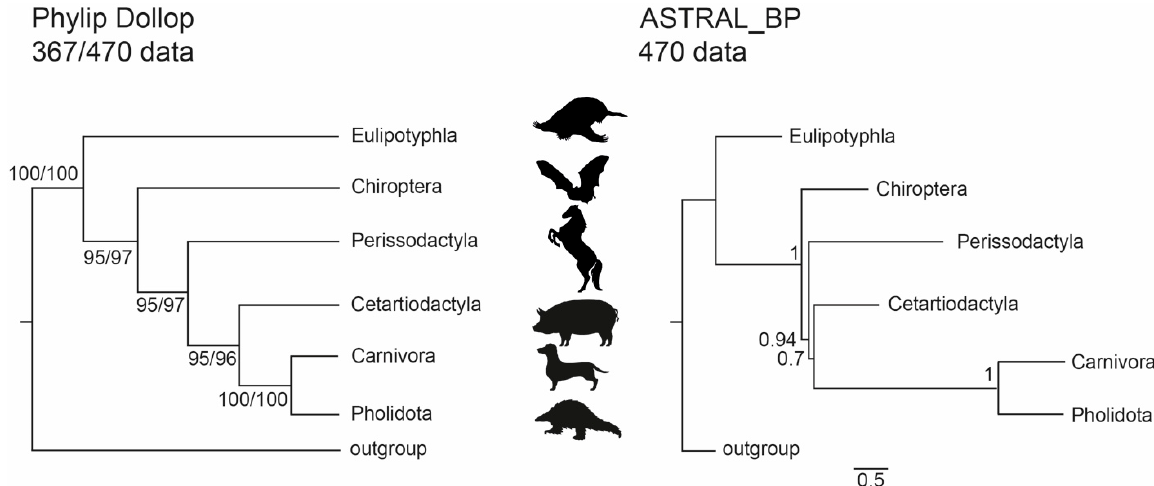
Figure 4. Species tree for Laurasiatheria based on retrotransposon presence/absence data. The tree on the left is the most parsimonious tree with Dollo parsimony (261 and 360 steps for 367- and 470-marker datasets, respectively) and was obtained with the Dollop program in Phylip. The tree on the right was obtained with the coalescence method ASTRAL_BP. Numbers on the left are bootstrap support values; numbers on the right are local posterior probabilities. Dual bootstraps on the left show results for the new 367 TE dataset and the 470 TE dataset after adding non-overlapping data from Doronina et al. [36]. The branch lengths for the ASTRAL_BP tree, in coalescent units, are indicated by the scale bar.